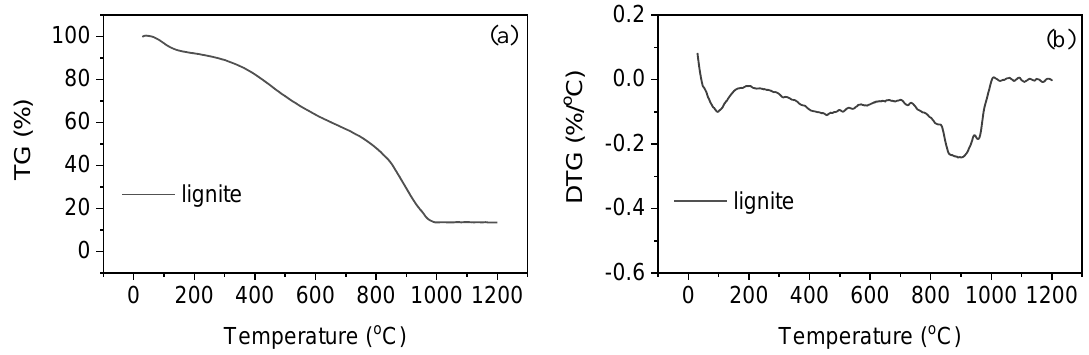
Figure 7. ( a ) TG curves of gasification of lignite; ( b ) DTG curves of gasification of lignite.